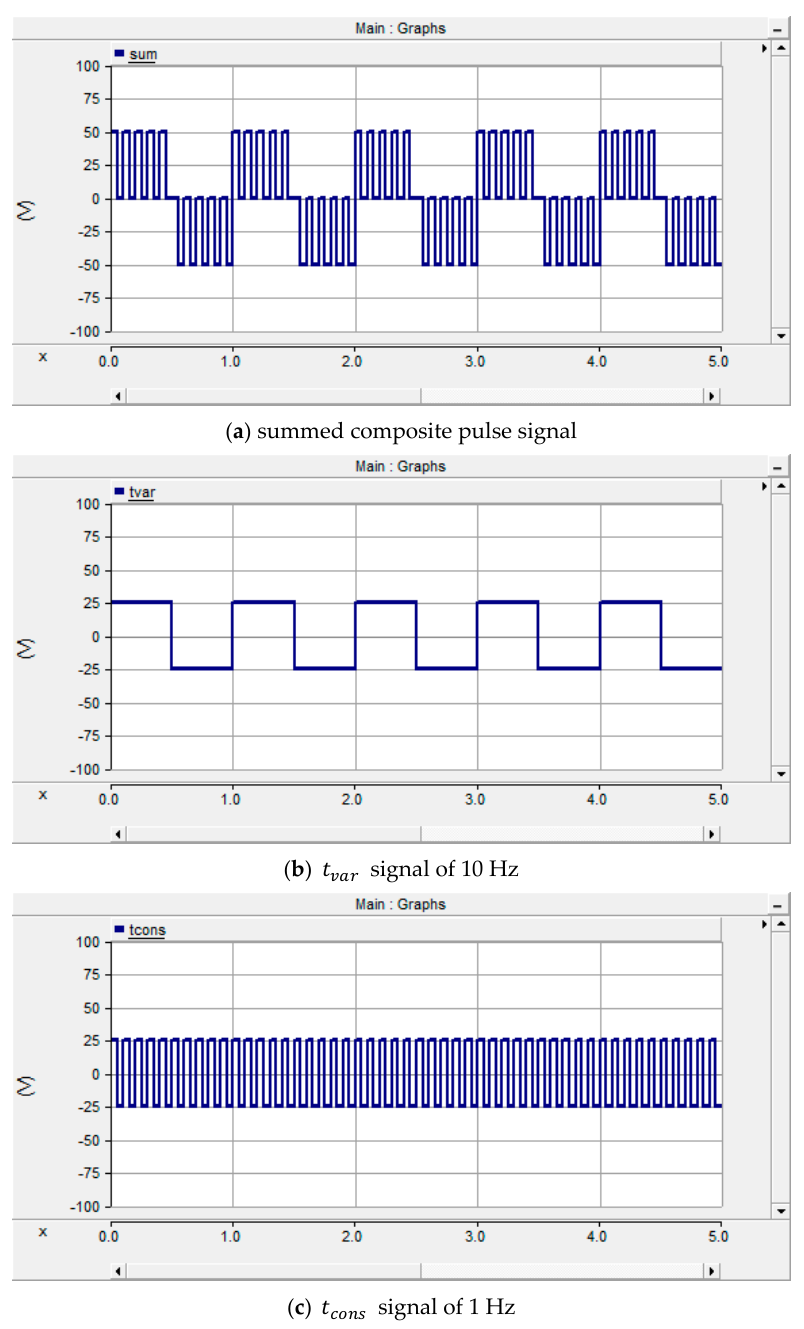
Figure 6. The injected pulse signal of the pulsating signal generator.